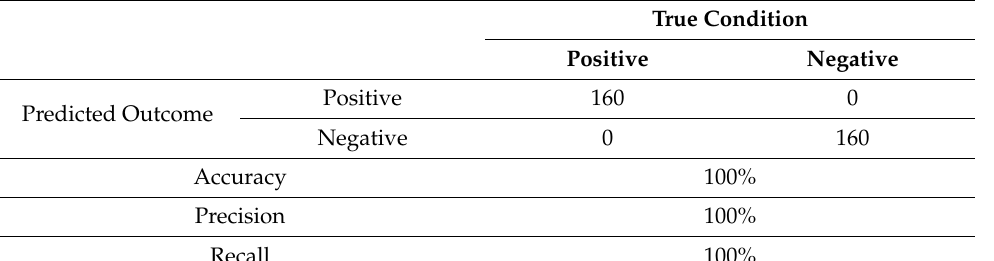
Table 6. Confusion matrix of the defect result with DK.